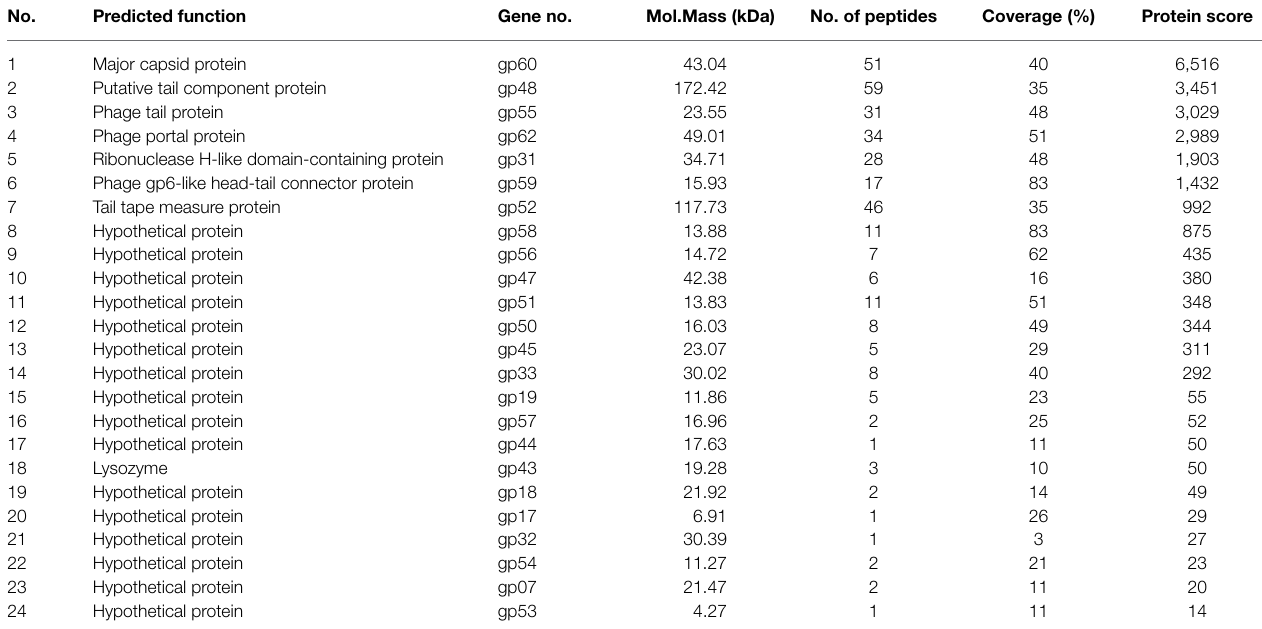
TABLE 3 | Genes encoding virion proteins in BUCT603 identified by mass